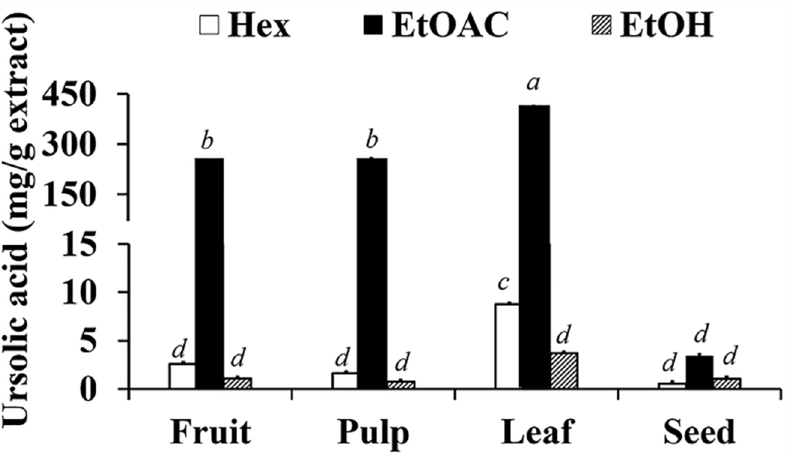
Figure 2. Ursolic acid content of C. carandas extracts sequentially extracted using n -hexane (Hex), ethyl acetate (EtOAc), and 95% ethanol (EtOH), respectively. The letter a , b , c , and d denote significant difference among different C. carandas extracts ( p < 0.05) after being analyzed by one-way ANOVA followed by Tukey’s test.